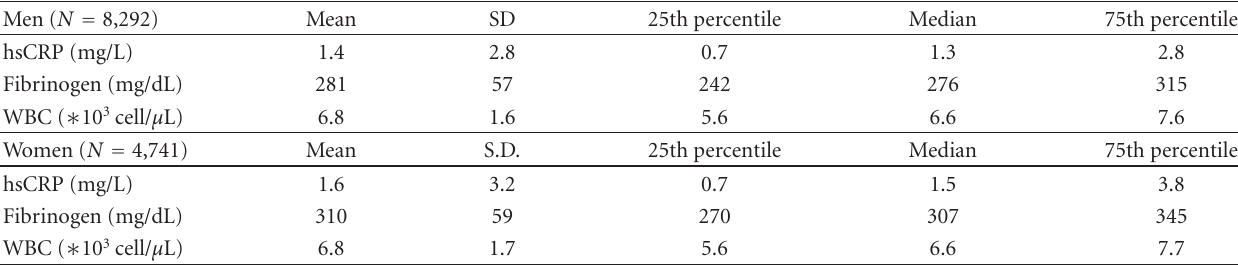
Table 3: Mean, SD and the quartiles of the di ff erent inflammatory variables, in men (upper part) and women (lower part). Men ( N = 8,292)